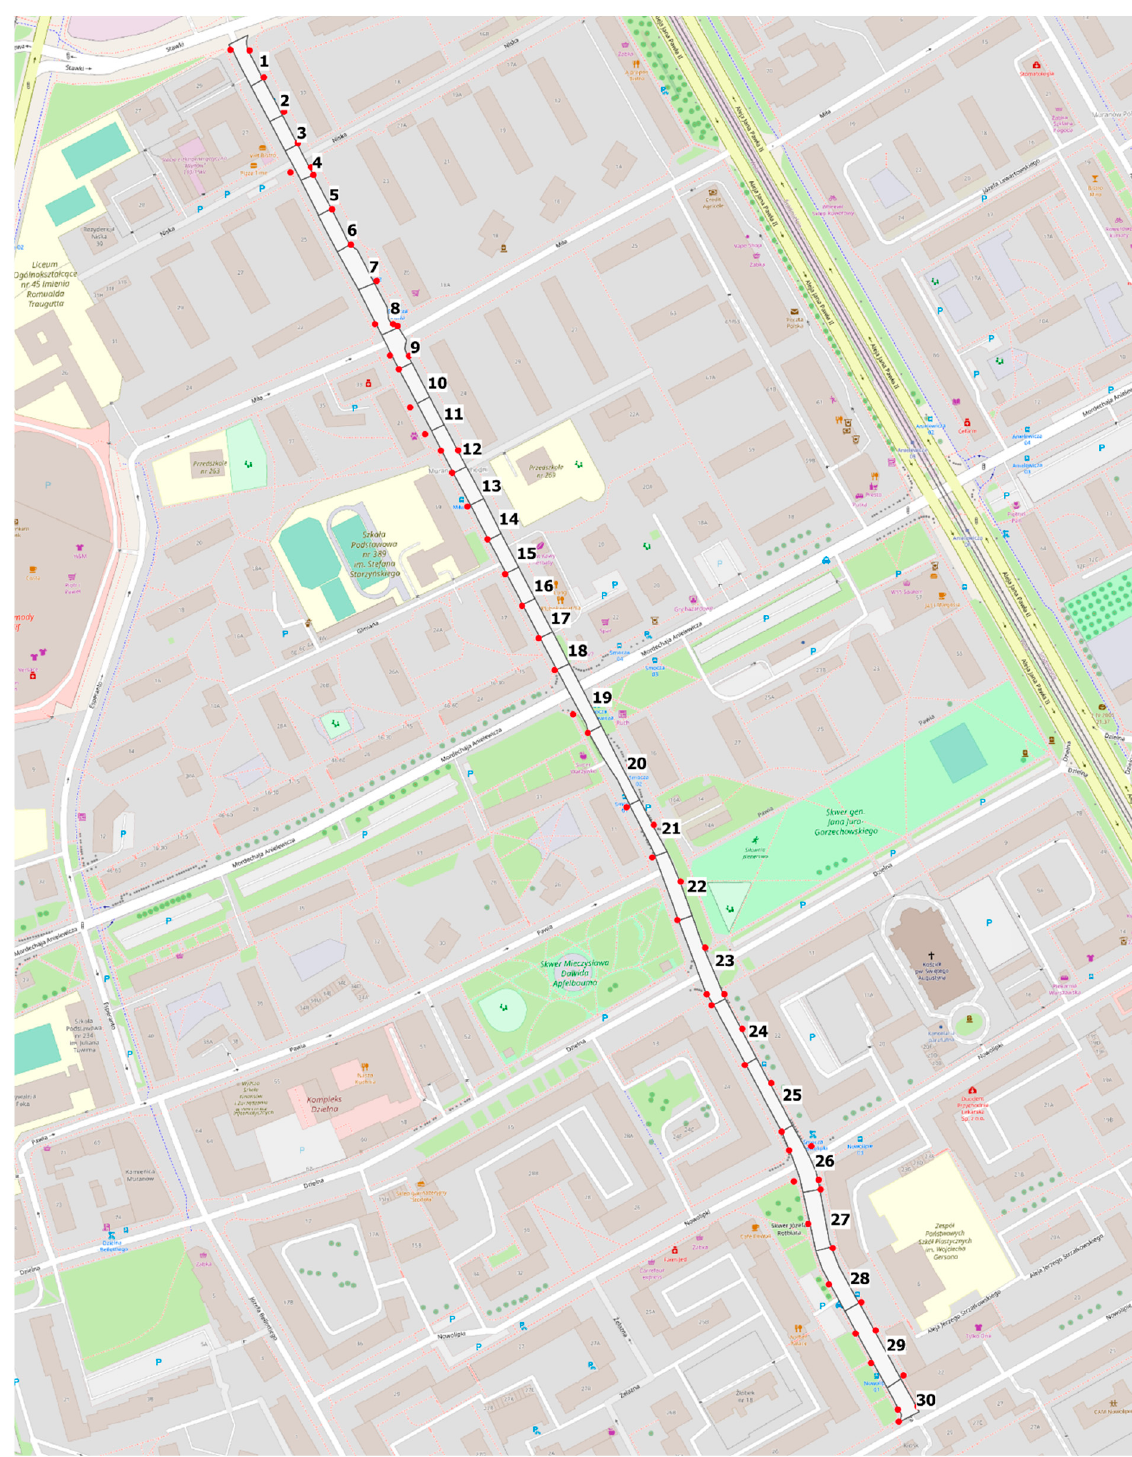
Figure 5. Arrangement of measuring sections and luminaire locations.